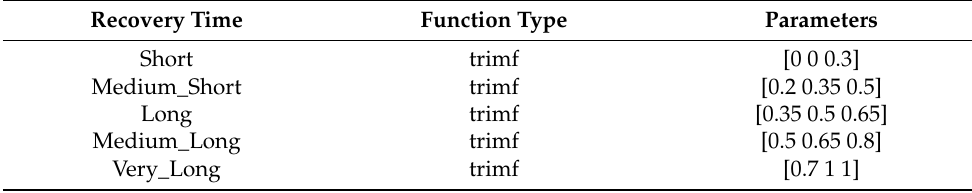
Table 7. Recovery time membership functions with five terms.